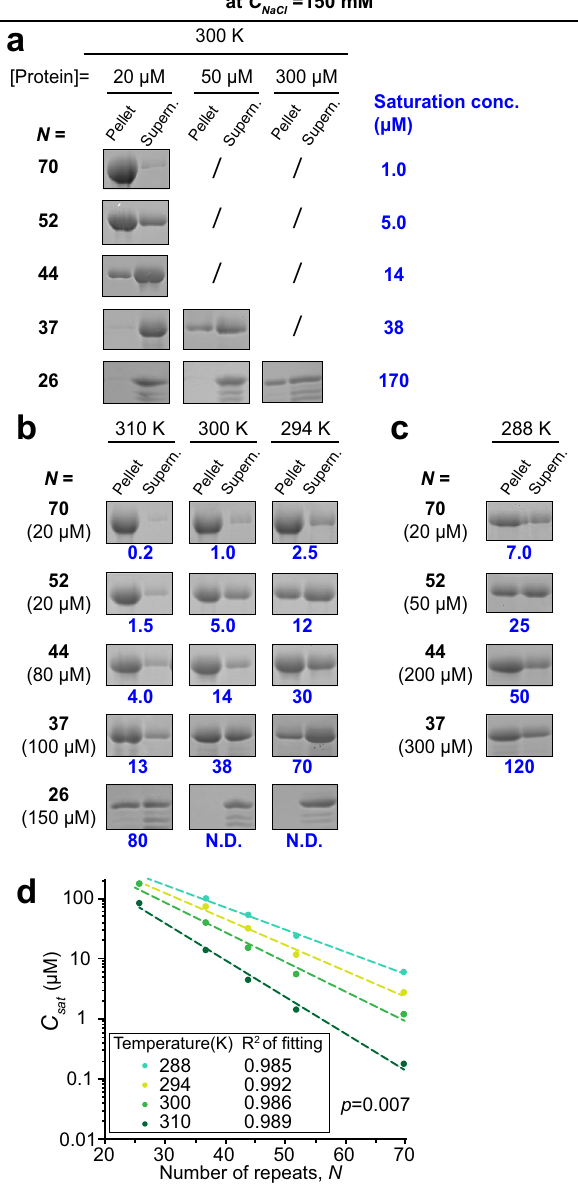
(Fig. 1d), but derived with an orthogonal method. On the other hand,